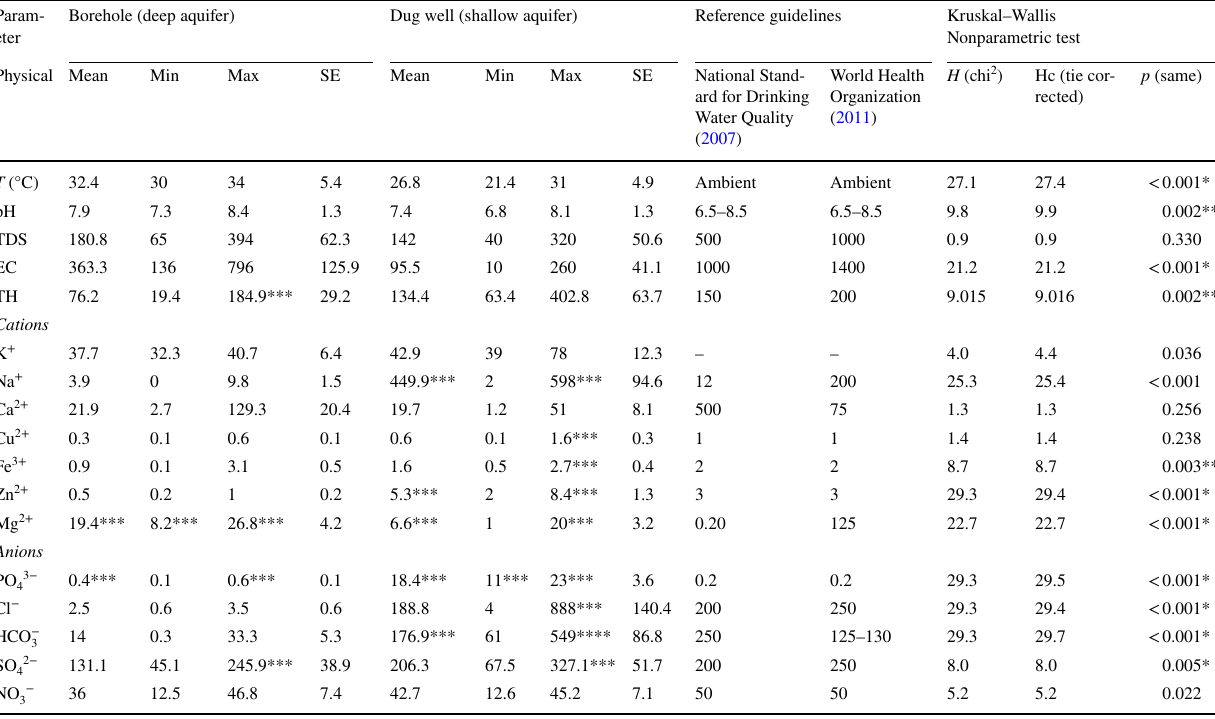
***Do not follow WHO and/or NSDWQ reference guidelines *Significant difference between shallow and deep groundwater < 0001; **significant difference between shallow and deep groundwater ≤ 0.005